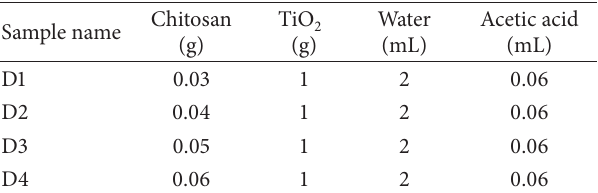
Table 1: Composition of the as-prepared chitosan sol-based TiO pastes used in this study.